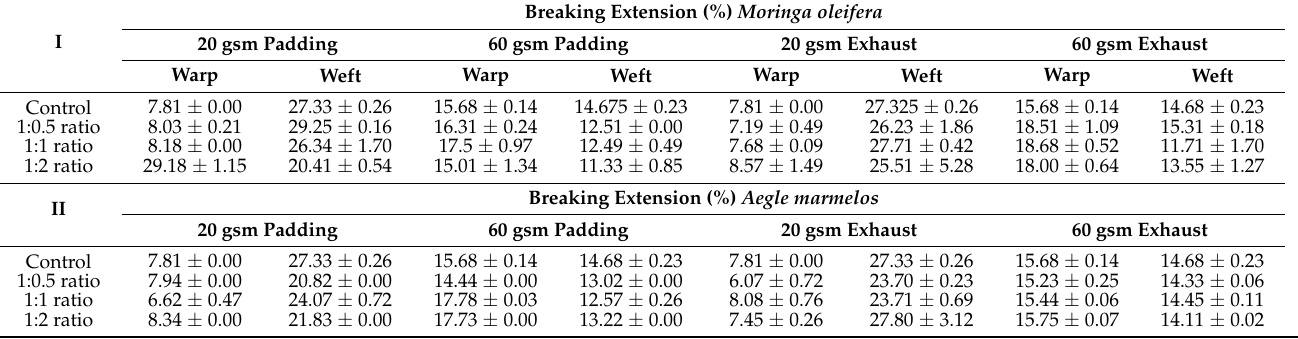
Table A1. Tensile strength-elongation values for 20 and 60 gsm fabrics treated with nano-emulsion 1 and 2 from padded and exhaust